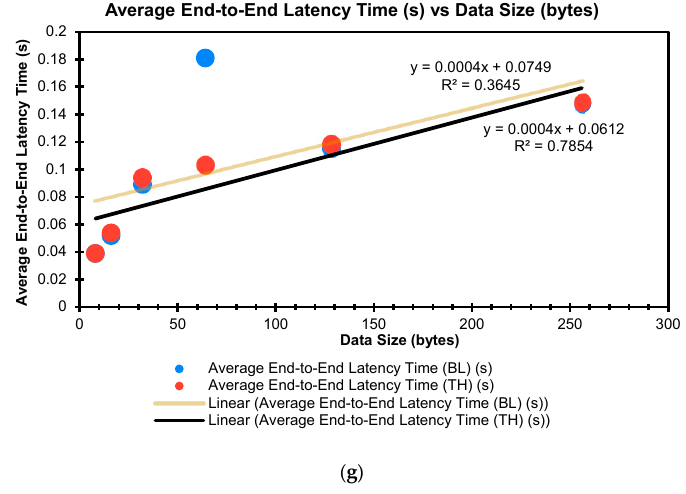
Figure 18. The graph for Average End-To-End Latency time against Data packet size for all connection pairs: ( a ) Zigbee to Zigbee; ( b ) Bluetooth to Bluetooth; ( c ) Thread to Thread; ( d ) Zigbee to Bluetooth; ( e ) Zigbee to Thread; ( f ) Thread to Zigbee; ( g ) Zigbee to all—Mesh broadcast (20 m range with wall barrier).